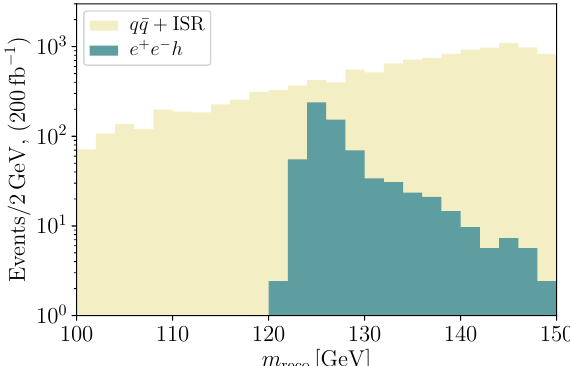
+ e Figure 4 . Comparison of the m (cid:0) ) h signal and q (cid:22) q + ISR back- reco distribution for the Z ( ! e ground for track only-based electron candidates with no isolation requirements for 200 fb (cid:0) 1 of integrated luminosity. The lack of any isolation requirement results in a large q (cid:22) q +ISR contribution where charged hadrons within jets fake track based electron candidates. This background can be substantially reduced by the track isolation requirements discussed in the